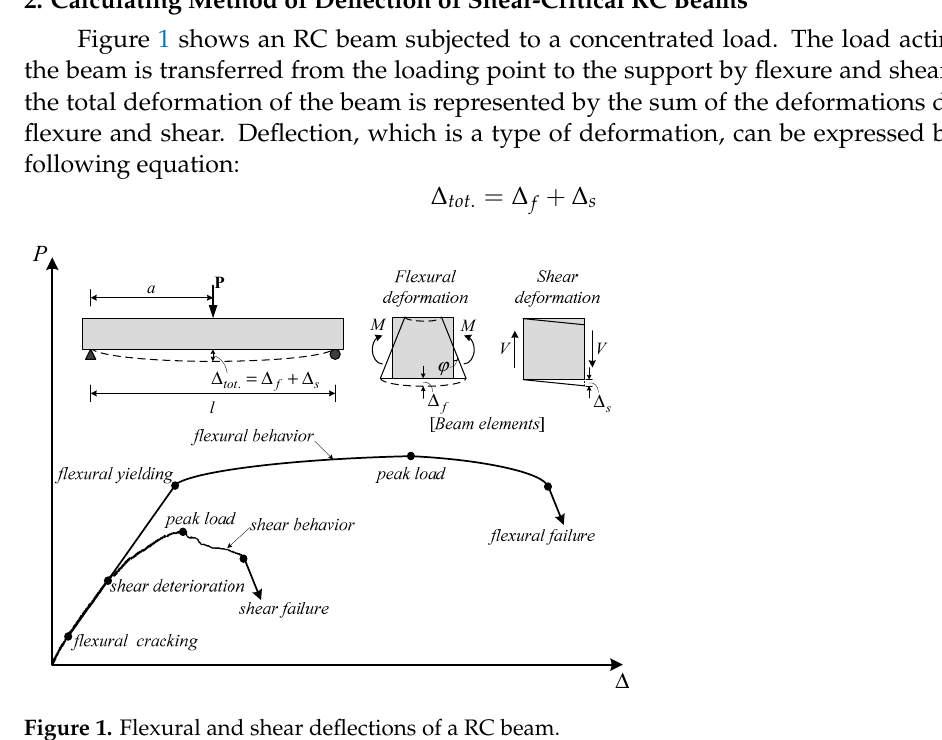
Figure 1. Flexural and shear deflections of a RC beam.